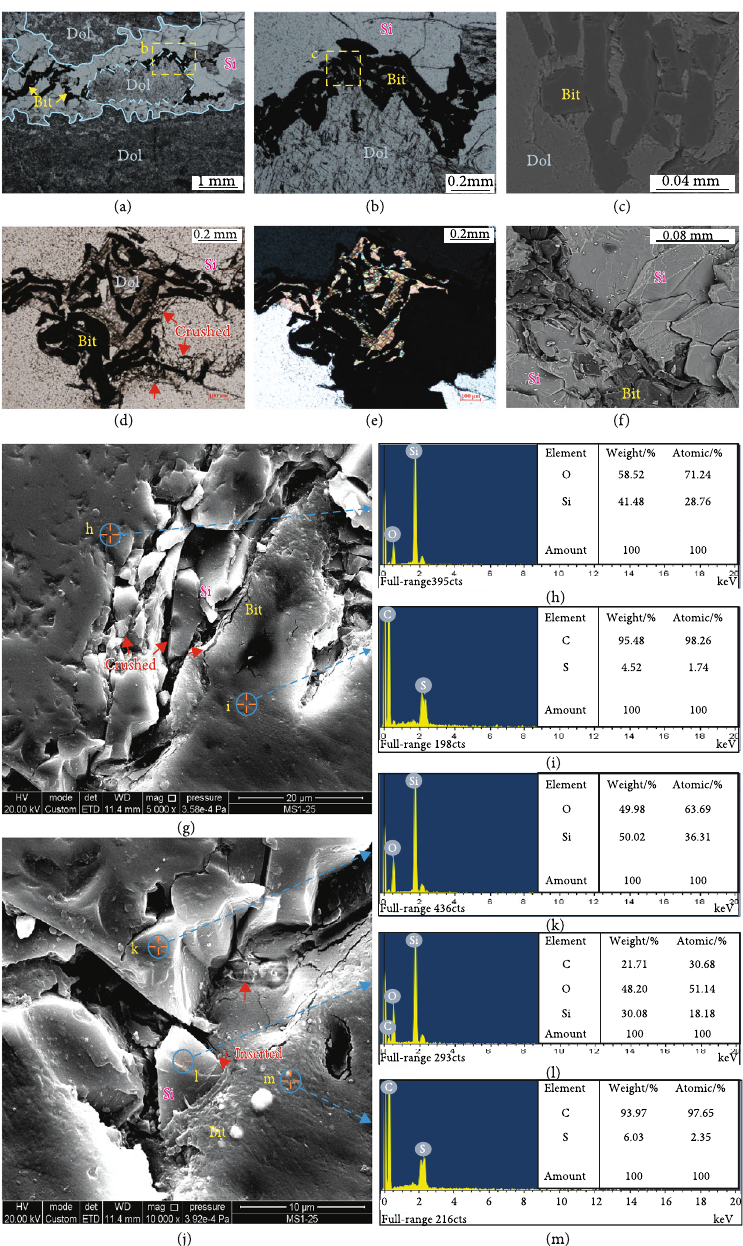
Figure 5: Chart of pore and fi lling mineral morphology of the MS well #1 Z dn 4 member. (a) Interior of solution pore with a pore size 2 exceeding 2mm, fully fi lled with authigenic quartz, recrystallised dolomite and bitumen. Among them, recrystallised dolomite has a large crystal size, good crystal shape, and granular bitumen morphology; bitumen is scattered between the grains of authigenic quartz or between the grains contacted by authigenic quartz and dolomite (sample depth is 8,055.32 m); (b) close up of part (a), where the contact relationship of minerals shows that bitumen is distributed in granular form between authigenic quartz and recrystallised dolomite crystals, and some bitumen is embedded in the contact crystal; (c) close up of (b), showing broken granular bitumen; (d) several minerals in the pores are closely contacted, and the recrystallised dolomite with good crystal form is extruded and broken. Bitumen particles are mostly distributed within or between the crystals of other epigenetic minerals in the shape of extrusion embedding, and crushing cracks are more likely on the boundary of authigenic quartz crystal (sample depth is 8,053.97 m); (e) orthogonal polarisation of part (d); (g) contact relationship of minerals in pores under scanning electron microscope, in which the bending deformation and compressive cracks are more visible on the bitumen boundary contacting with quartz, and the extrusion fracture zone is more visible on the edge of autogenous quartz grains (sample depth is 8,055.16 m); (h) and (i) qualitative analysis of authigenic quartz and bitumen mineral composition in part (g); (j) bending deformation and compressive cracks of bitumen are more obvious, and broken quartz is inserted into bitumen (sample depth is 8,054.16 m); (k) – (m) qualitative analysis of authigenic quartz and bitumen mineral composition in part